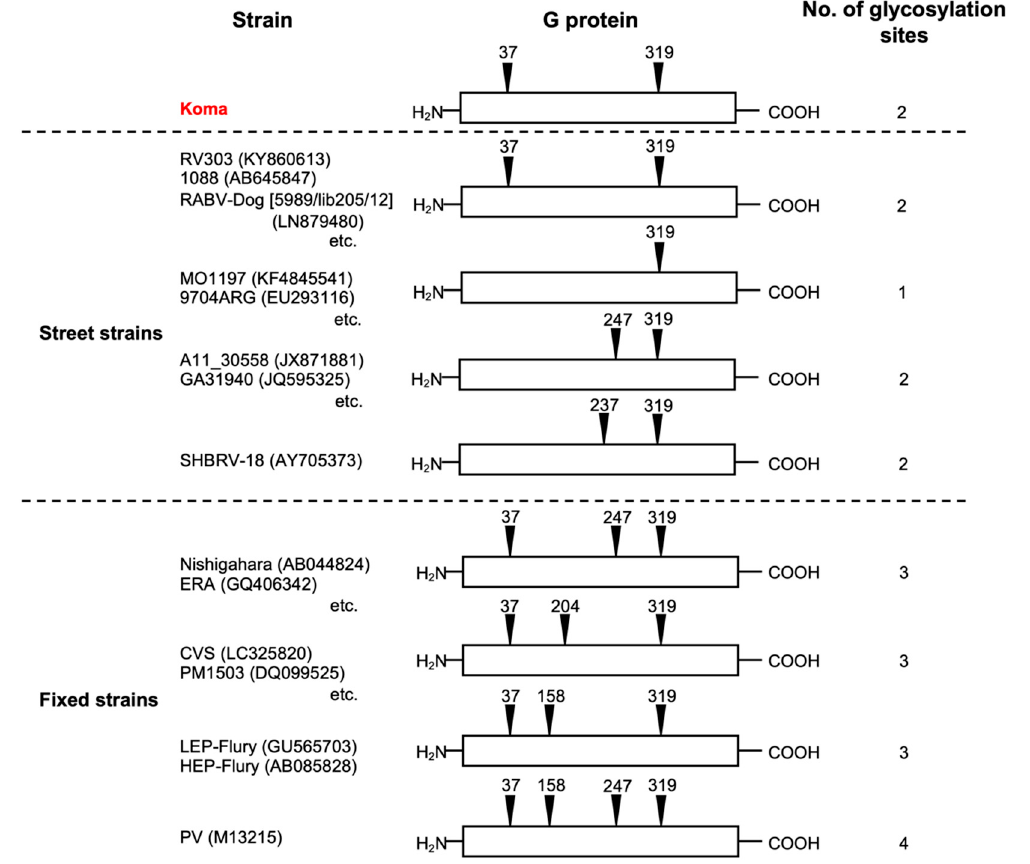
Figure 4. Positions and total numbers of potential N-glycosylation sites in the G protein of RABV strains. Black triangles with numbers represent the potential N-glycosylation sites. Information on the glycosylation sites in the street and fixed strain G proteins was obtained from articles by Yamada et al. [23] and Hamamoto et al. [47].